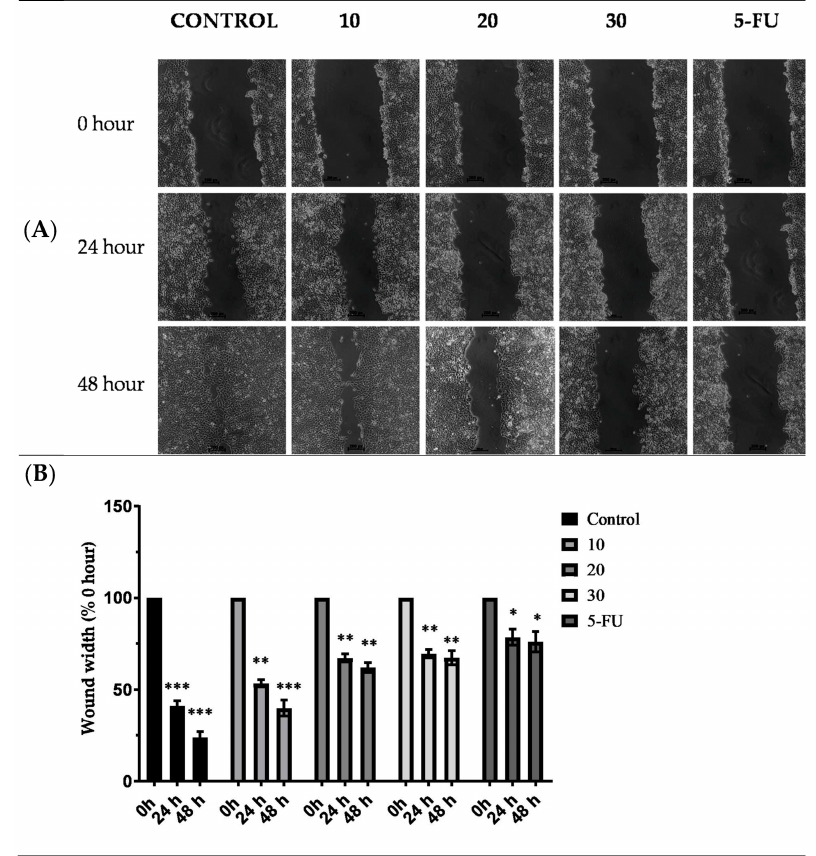
Figure 6. ( A ) TYH inhibited metastatic properties of HCT-116 cells. Inhibition of migration of HCT- 116 cells after treatment with 10, 20, and 30 µ g/mL of TYH extract and 5-FU (5 µ g/mL) for 24 and 48 h. ( B ) Quantitative representation of migration of HCT-116 cells by wound-healing assay. Results are presented as percentage control at 0 h and represent mean ± SD values from three independent experiments. * p < 0.05; ** p < 0.01; *** p < 0.001 vs. 0